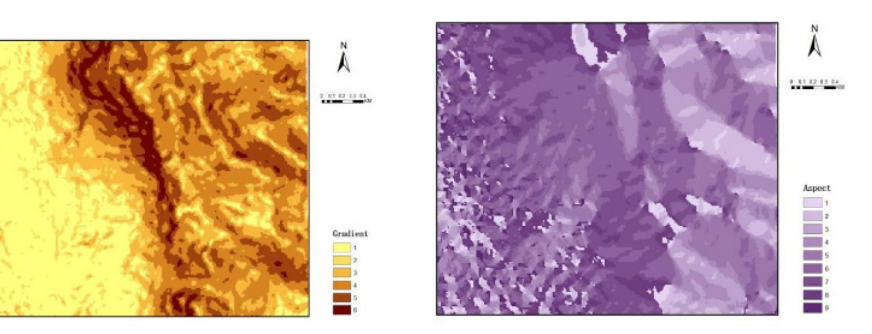
Fig. 5. Slope factor level. Fig. 6. Slope direction factor level.